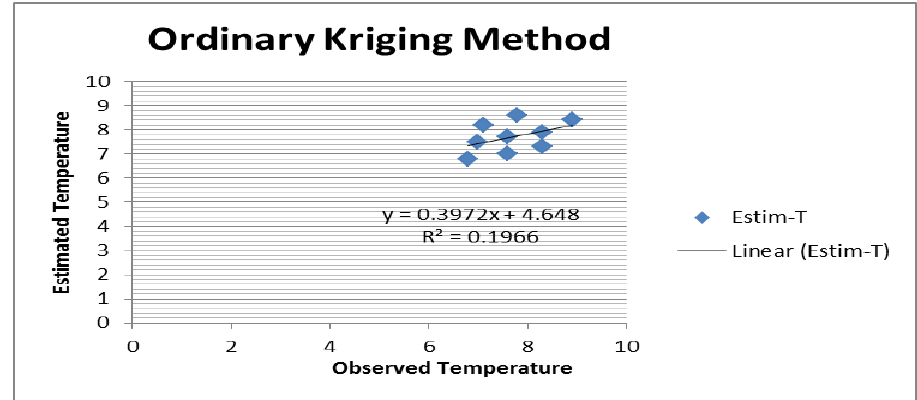
Fig.13: Ordinary kriging, comparison of estimated and observed mean